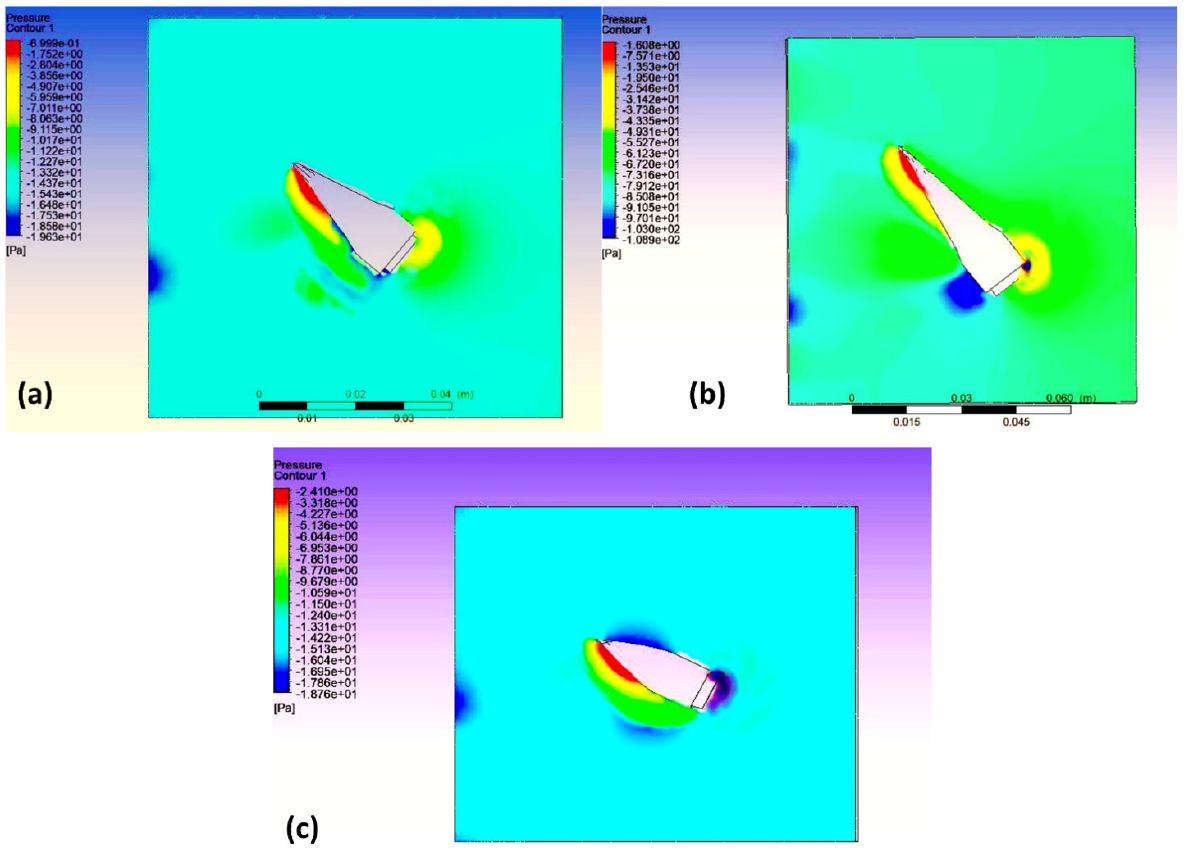
Figure 13. Pressure contour of ( a ) design I (105 mm) of bullet head at 30° angle of attack, ( b ) design I (130 mm) of bullet head at 40° angle of attack, and ( c ) design II (105 mm) of bullet head at 30° angle of attack.